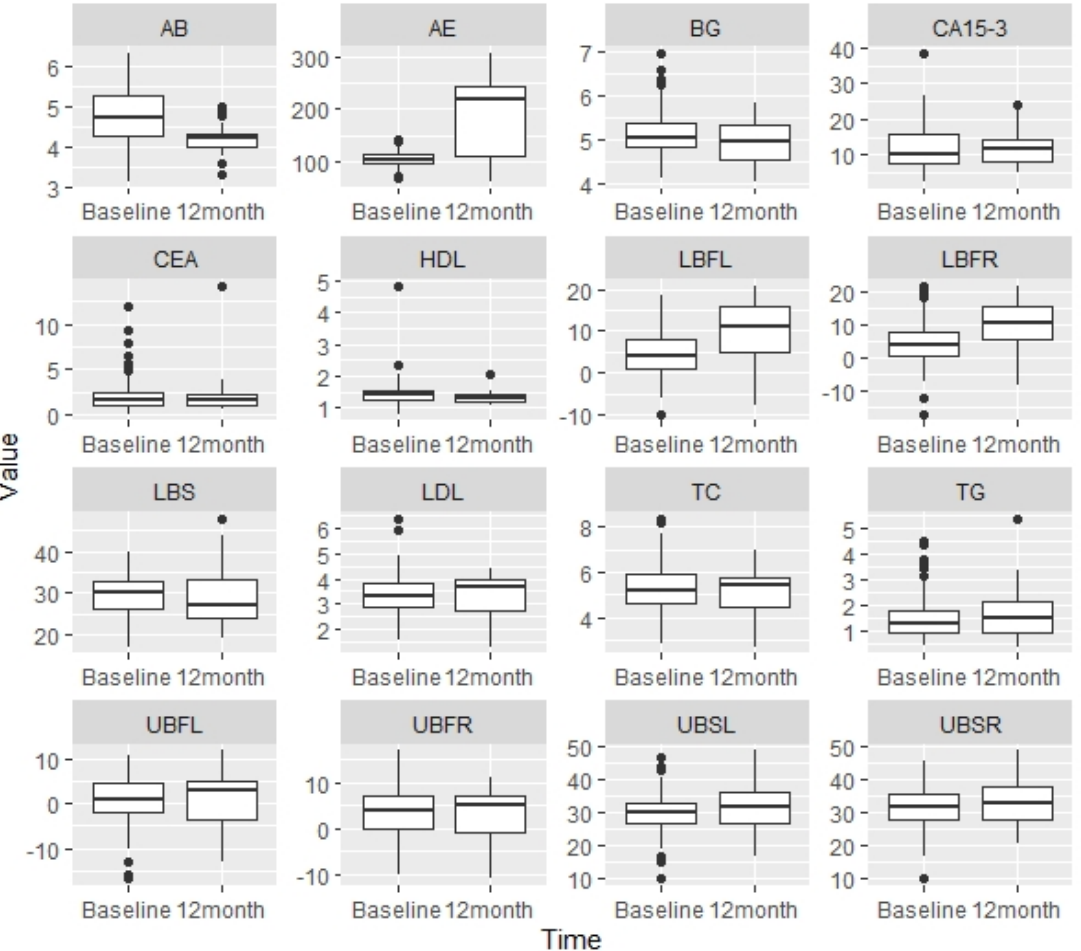
Figure 1. Comparisons between baseline and 12 months across all outcomes of interest. Note: AB = agility and balance; AE = aerobic endurance; BG = blood glucose; CA15-3 = cancer antigen 15-3; CEA = carcinoembryonic antigen; HDL = high-density lipoprotein; LBFL = lower-body flexibility left; LBFR = lower-body flexibility right; LDL = low-density lipoprotein; LBS = lower-body strength; UBFL = upper-body flexibility left; UBFR = upper-body flexibility right; TC = total cholesterol; TG = triglyceride; UBSL = upper-body strength left; UBSR = upper-body strength right.